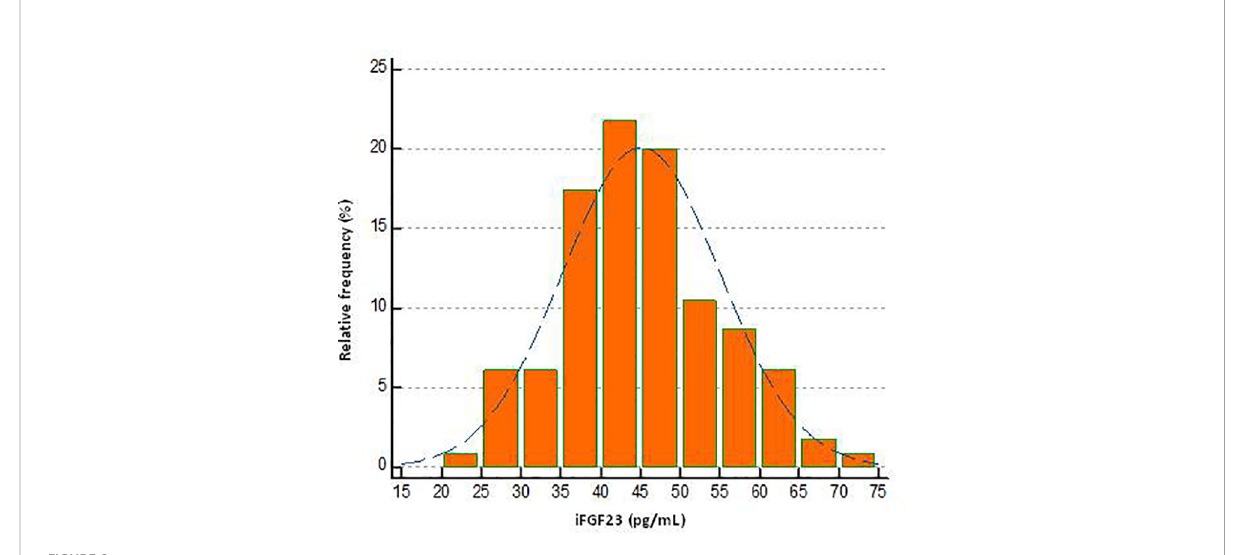
FIGURE 2 Frequency histogram of iFGF23 concentration in pediatric subjects